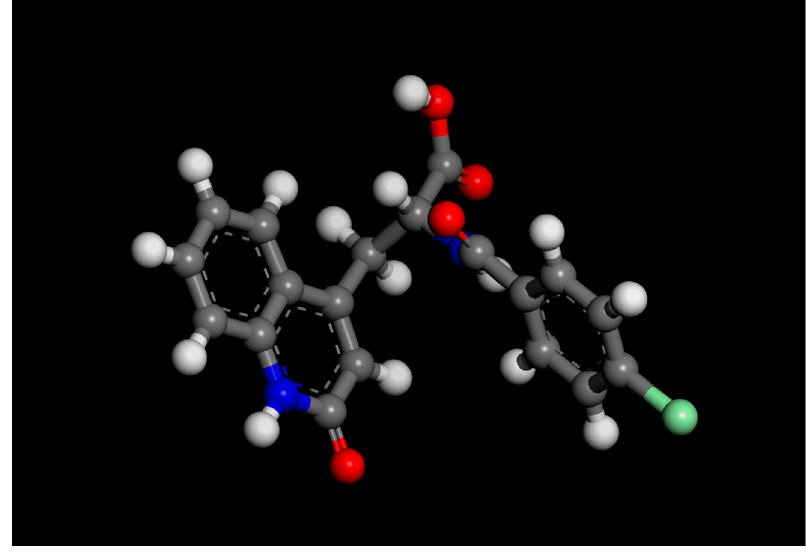
Figure 1. A rebamipide molecule structure.